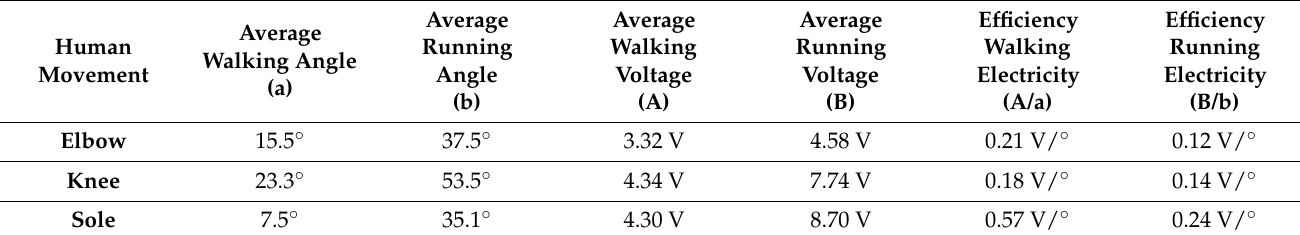
Table 4. Electricity efficiency to measure the angle change according to walking and running motions from the elbow, knee, and sole.